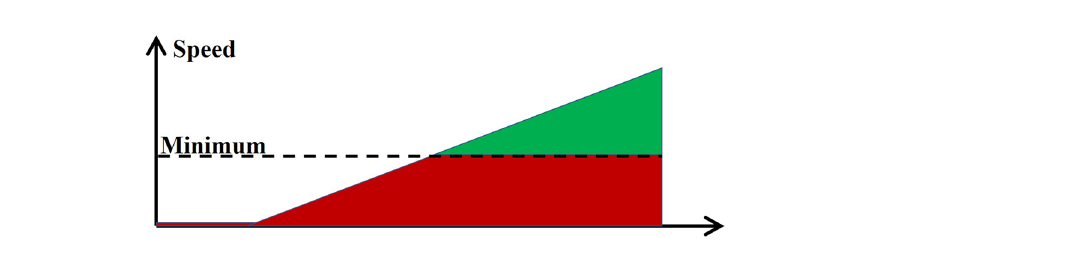
Figure 2. Red part represents low-speed, green